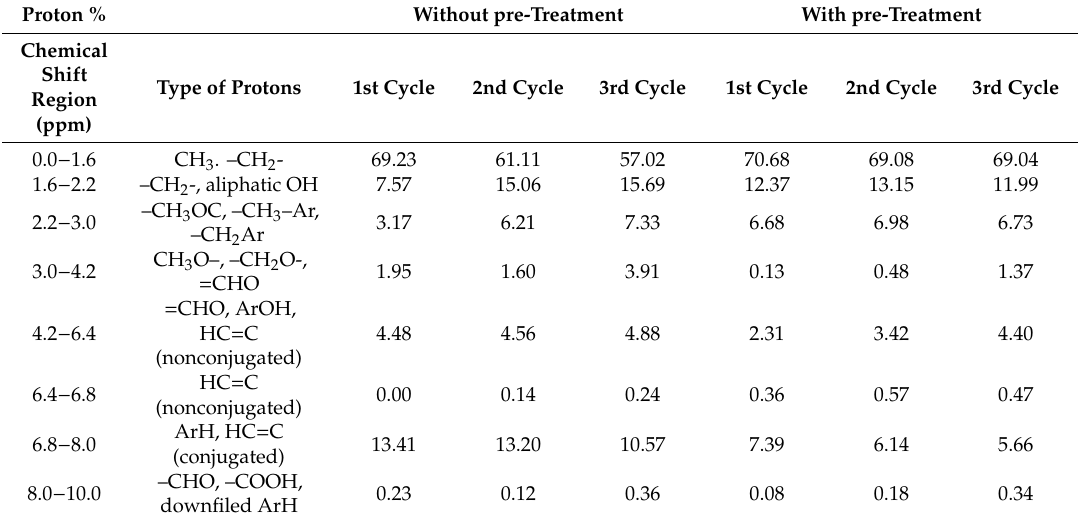
Table 3. 1 H-NMR integrations of treated and non-treated Isochrysis pyrolysis bio-oils versus specific chemical shift